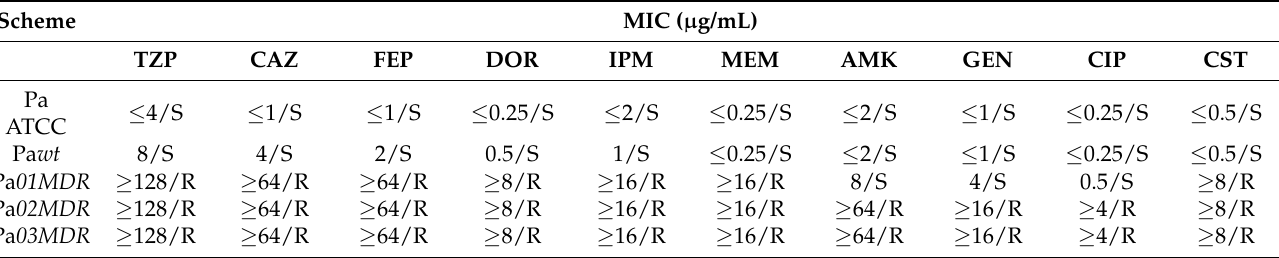
Table 1. Bacterial resistance profile from phenotypic tests.